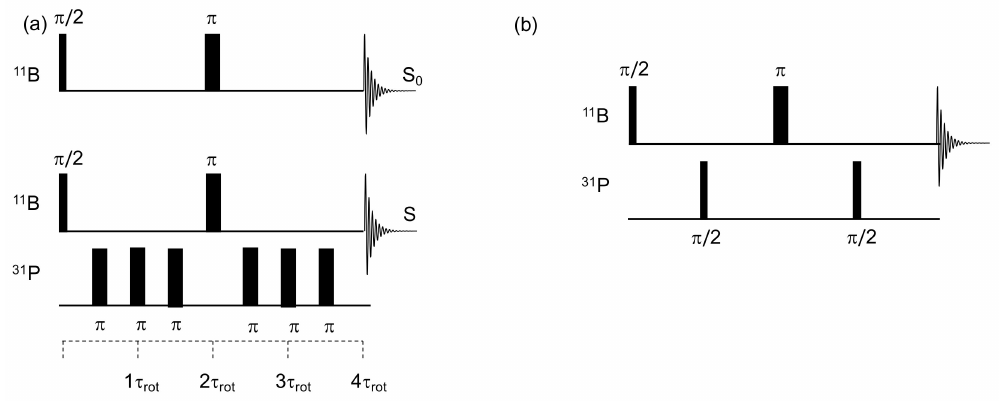
Figure 6. ( a ) 11 B( 31 P) rotational echo double resonance (REDOR) and ( b ) 11 B( 31 P) heteronuclear multiple quantum coherence (HMQC) pulse